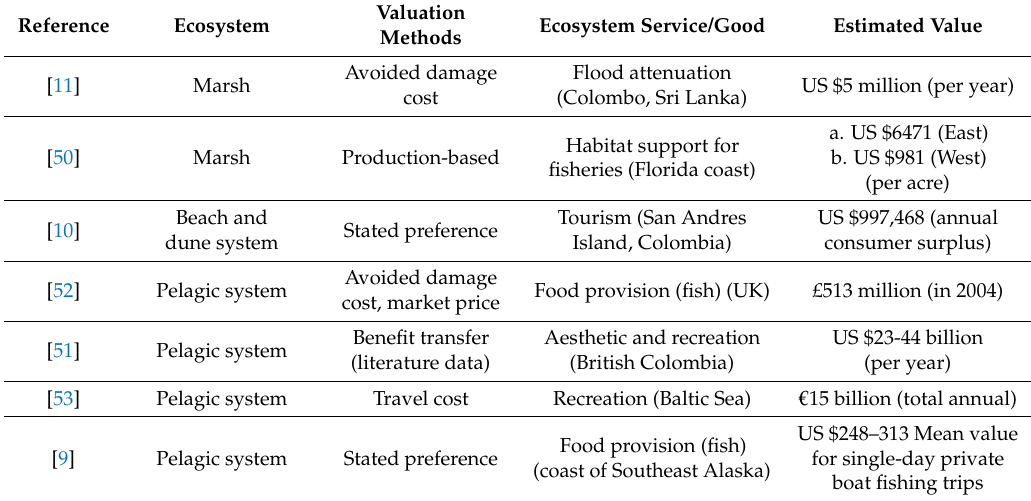
Table 6. Selected applications of valuations of other coastal